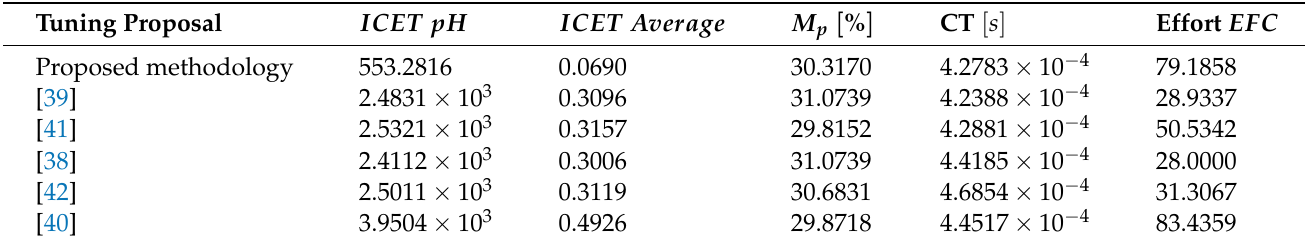
Table 6. Performance indices, CT: Computer